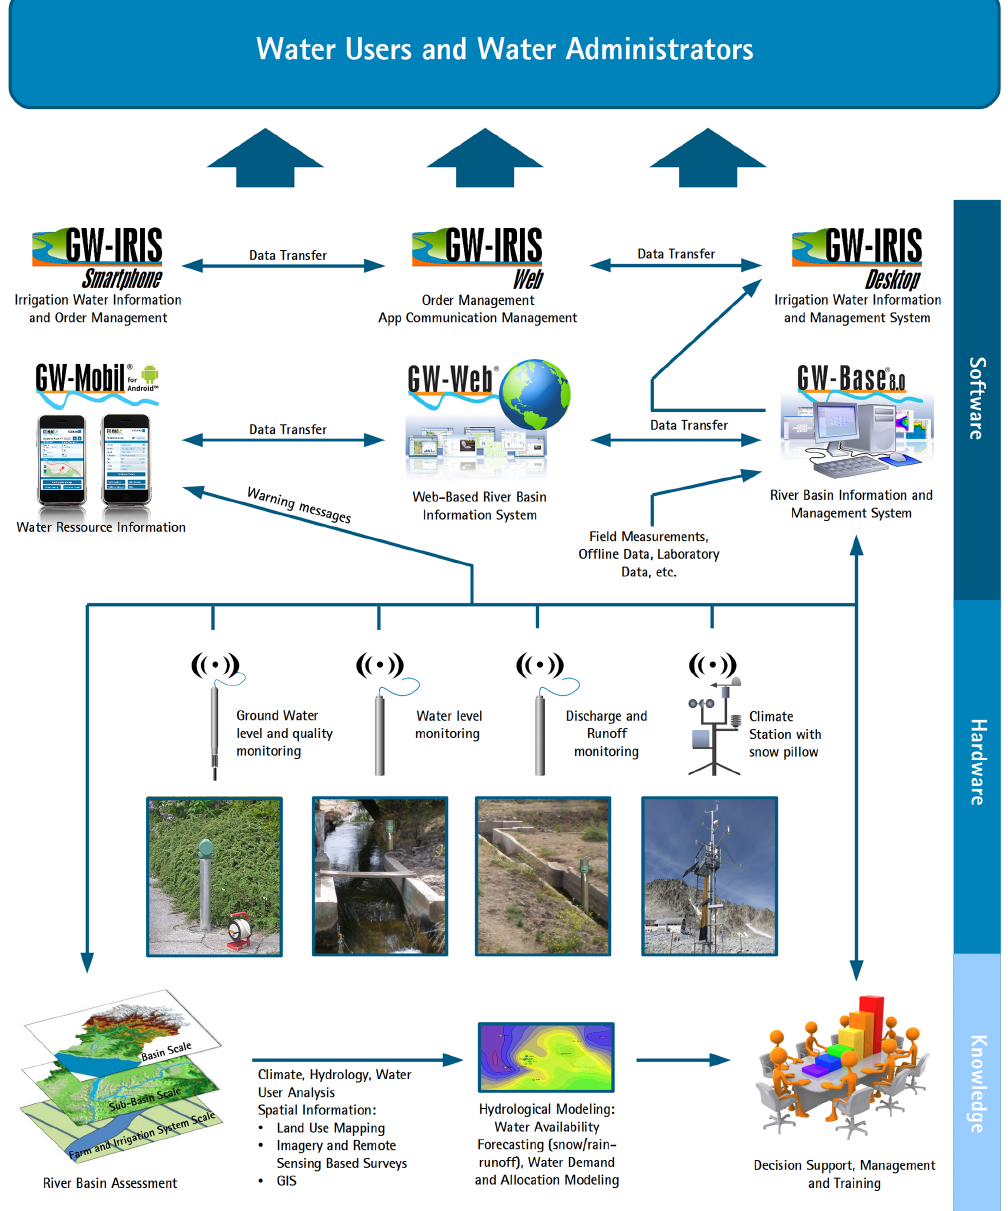
Figure 2. Communication scheme of the complete, newly developed WEIN